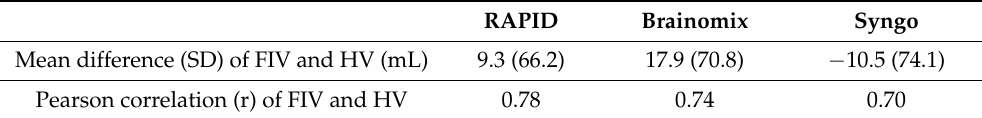
Table 2. Performance characteristics of the RAPID, Brainomix, and Syngo software—agreement of the hypoperfusion volumes (HVs) and the follow-up infarct volumes. RAPID Mean difference (SD) of FIV and HV (mL)